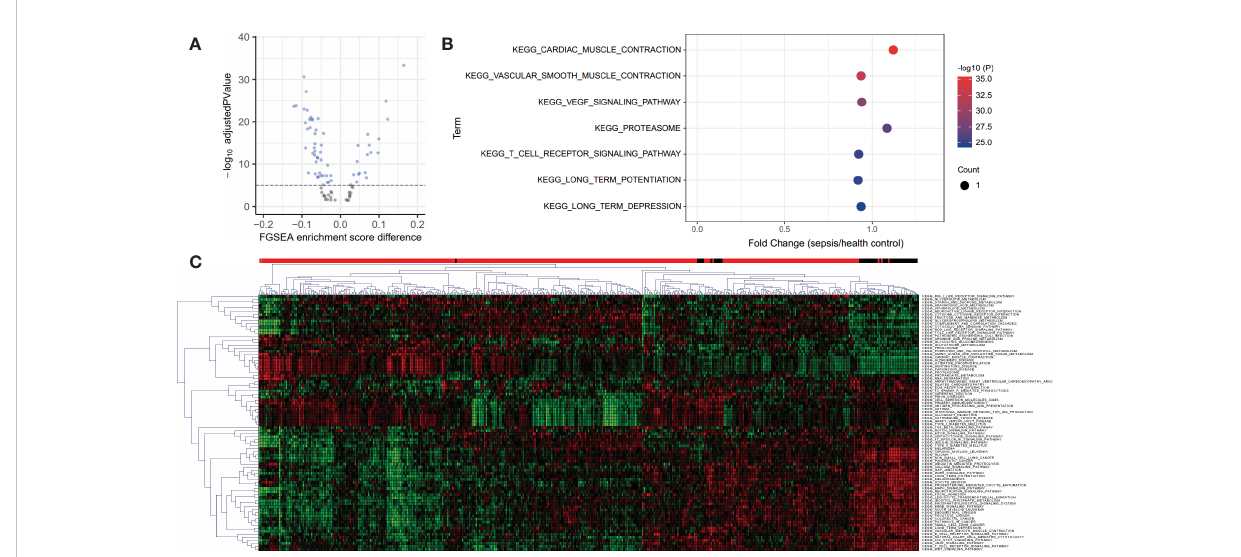
FIGURE 1 Volcano, bubble plots, and Clustering heatmap of the KEGG pathway differentially expressed in blood from healthy controls and septic patients in dataset GSE185263. (A) Volcano plot for 84 KEGG pathways altered in sepsis patients compared with healthy controls at adjusted P < 0.05. (B) Bubble plot for the top 7 most signi fi cant differentially expressed pathways. (C) Clustering heatmap based on 84 differential KEGG pathways reveals the heterogeneity of sepsis. The above bar indicates sample status, red: sepsis and black: healthy